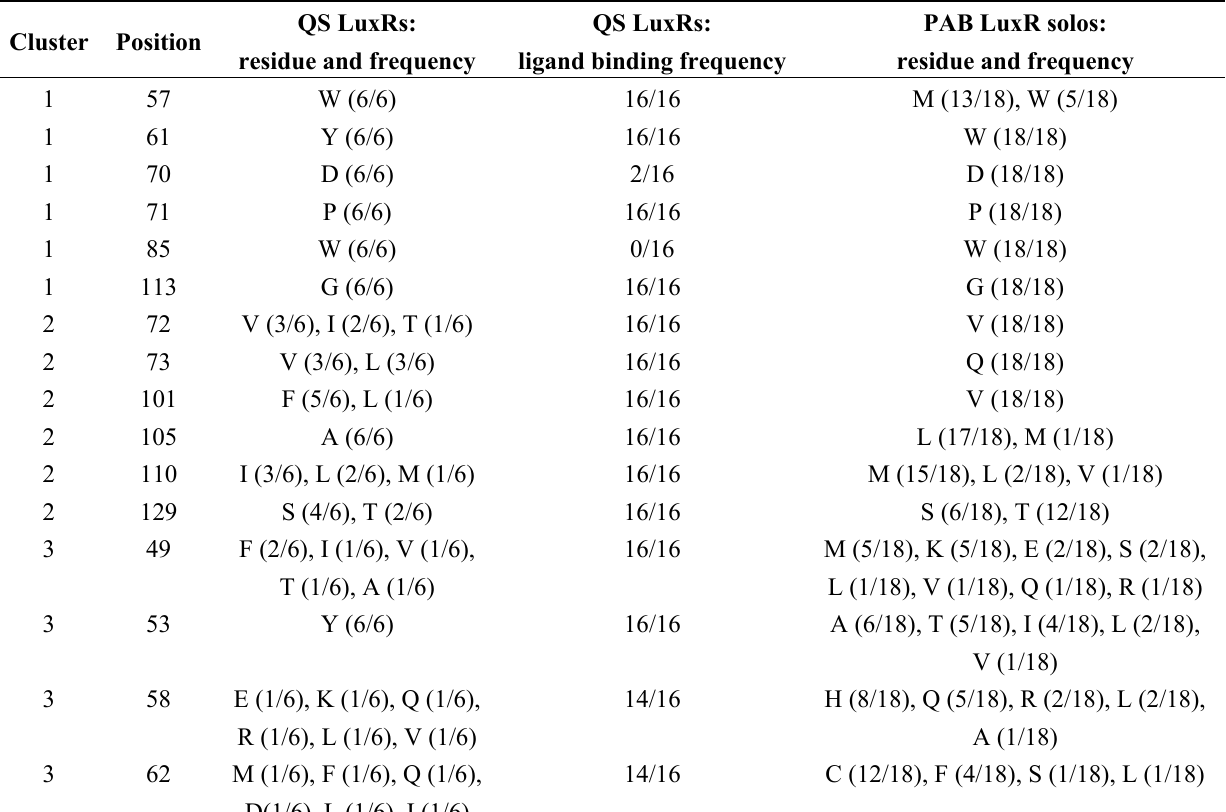
Table 1. Clusters residue type and frequency in the ligand-binding site of the regulatory domain of QS LuxRs and of the PAB LuxR solos subfamily.